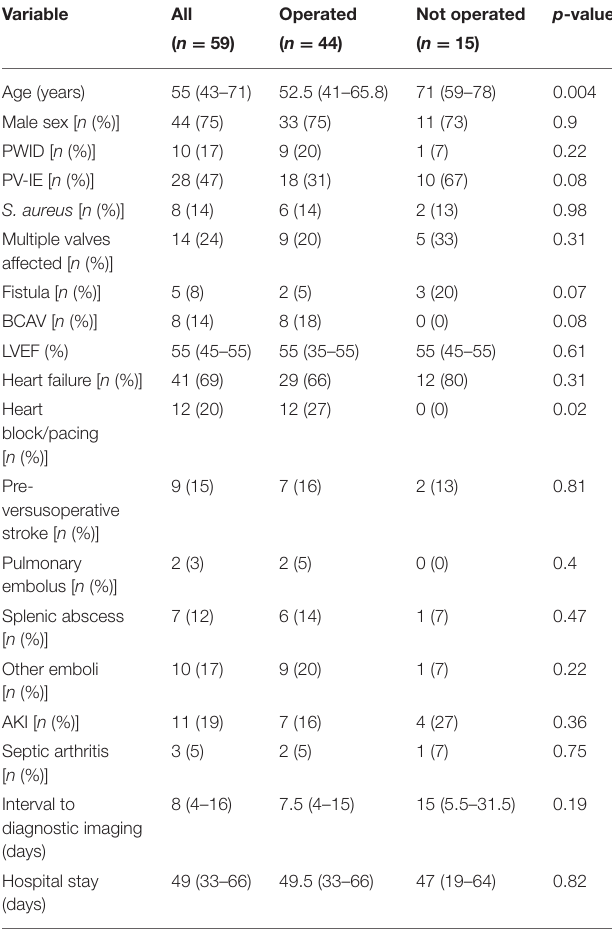
TABLE 2 | Operative data for patients with aortic root abscess undergoing AVR and ARR. Variable All